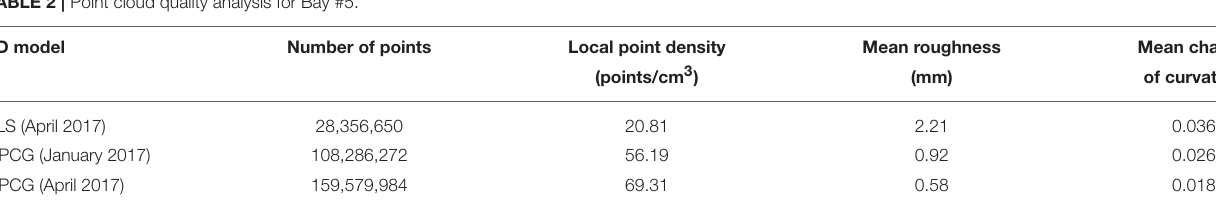
TABLE 2 | Point cloud quality analysis for Bay